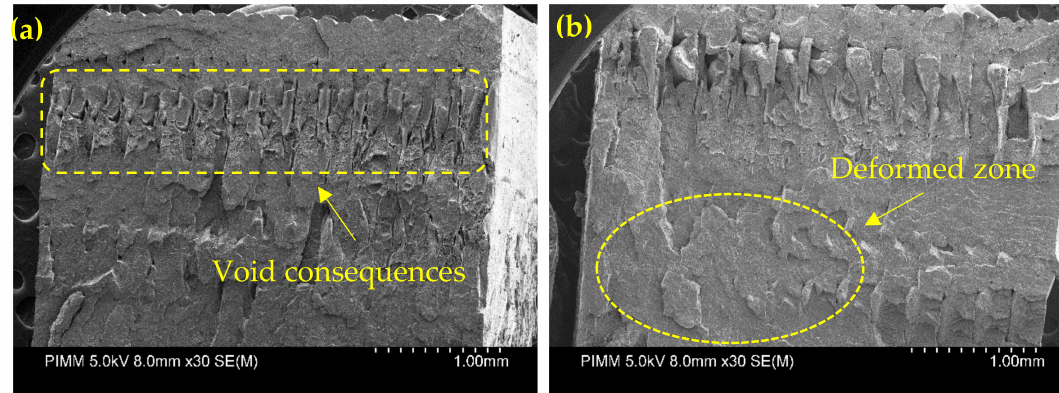
Figure 6. SEM micrograph for tensile fracture surface of the specimen in ( a ) condition III-1 and ( b ) condition III-3.